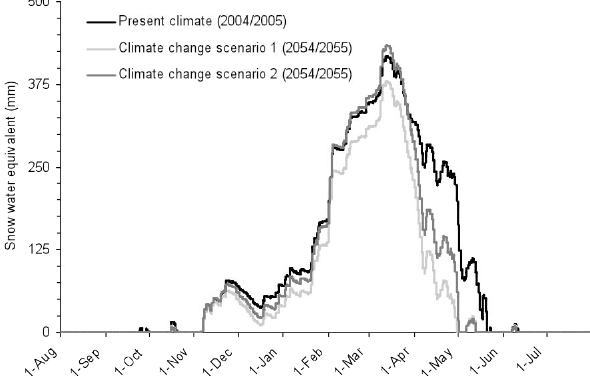
Fig. 5. Simulated snow water equivalent at the Kuehroint site under present and potential future climate